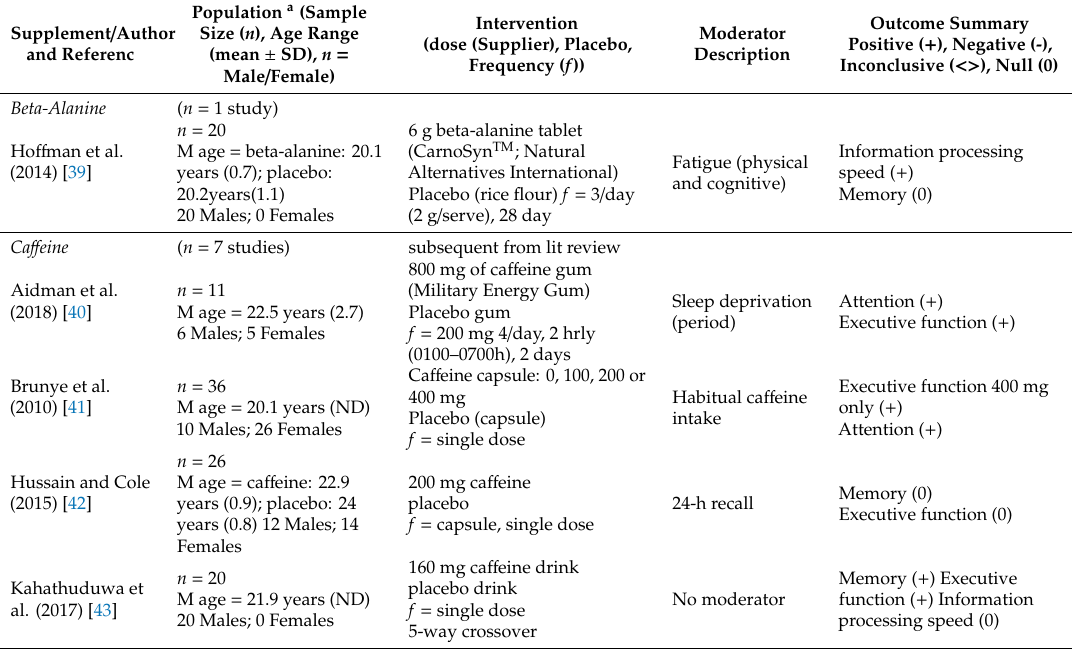
Table 3. Summary of evidence of included